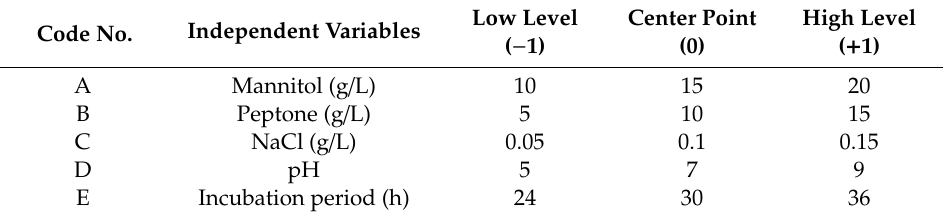
Table 1. Di ff erent levels ( − 1, 0, + 1) of the independent variables were used for the investigated ranges. Code